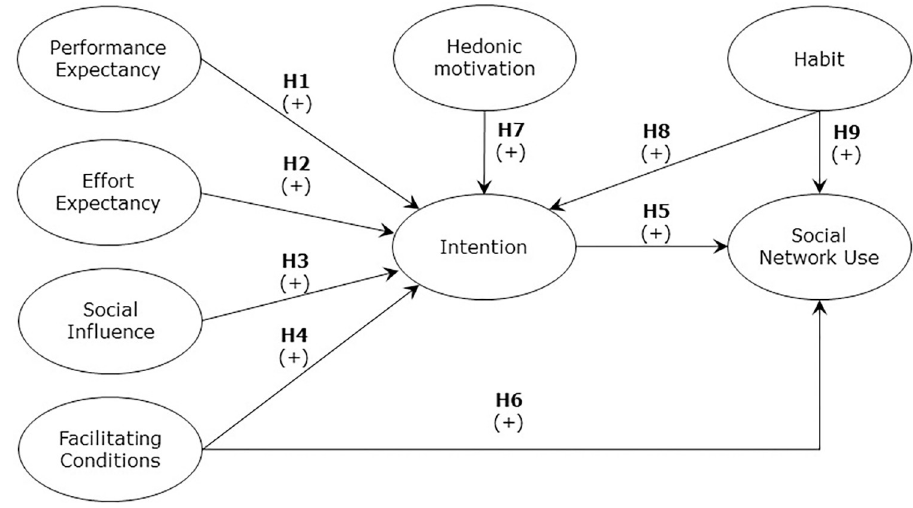
Fig 1. Research model and